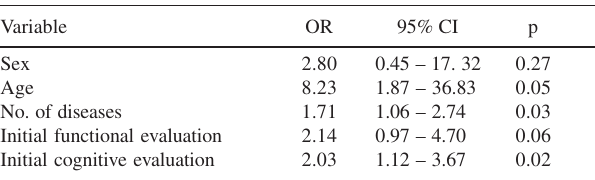
Table 6 - Univariate analysis of present cognitive evaluation